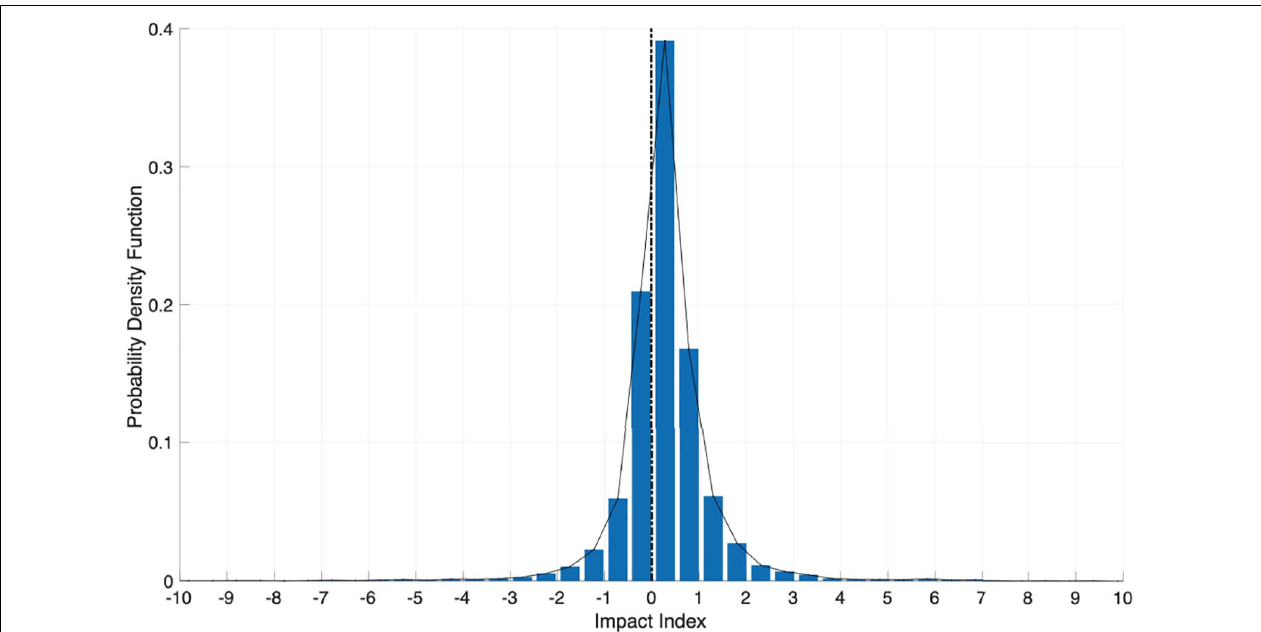
FIGURE 5 | PDF of SCI values estimated along the loggerhead turtle (LT)